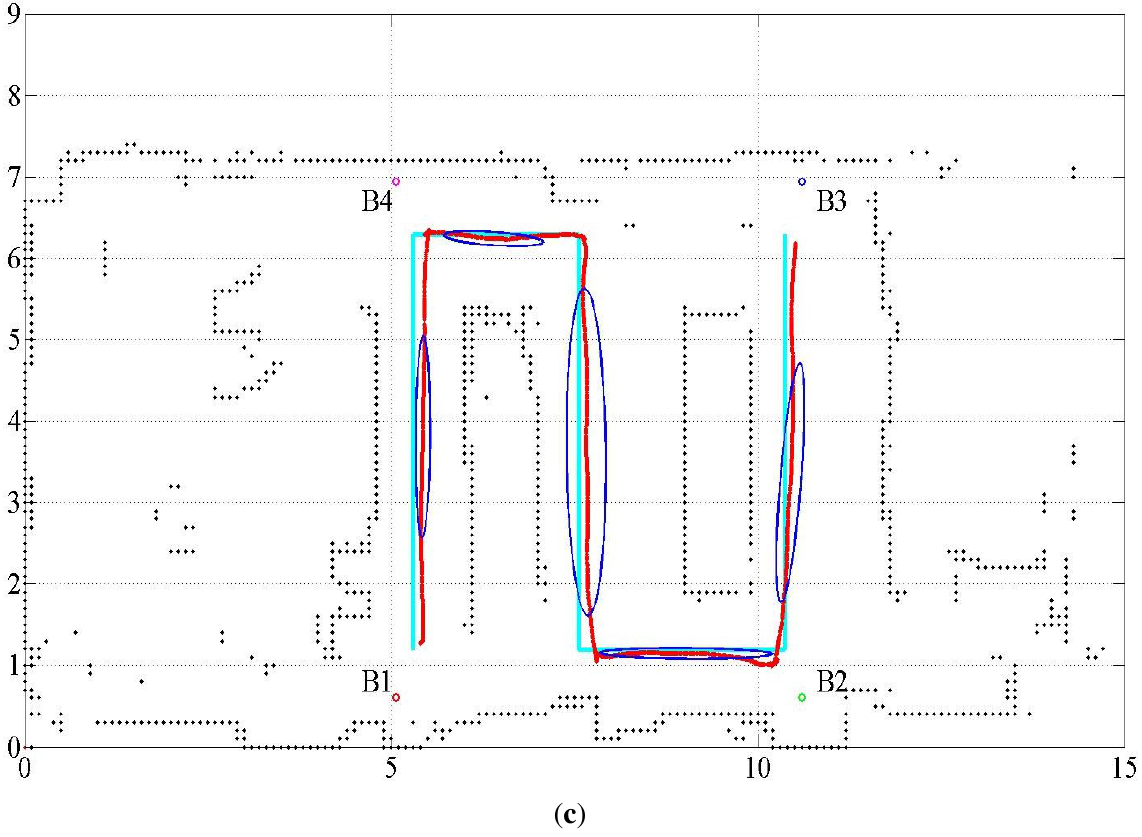
Figure 3. Estimated robot trajectory for the three cases. ( a ) Estimated trajectory for Case 1; ( b ) estimated trajectory for Case 2; ( c ) estimated trajectory for Case